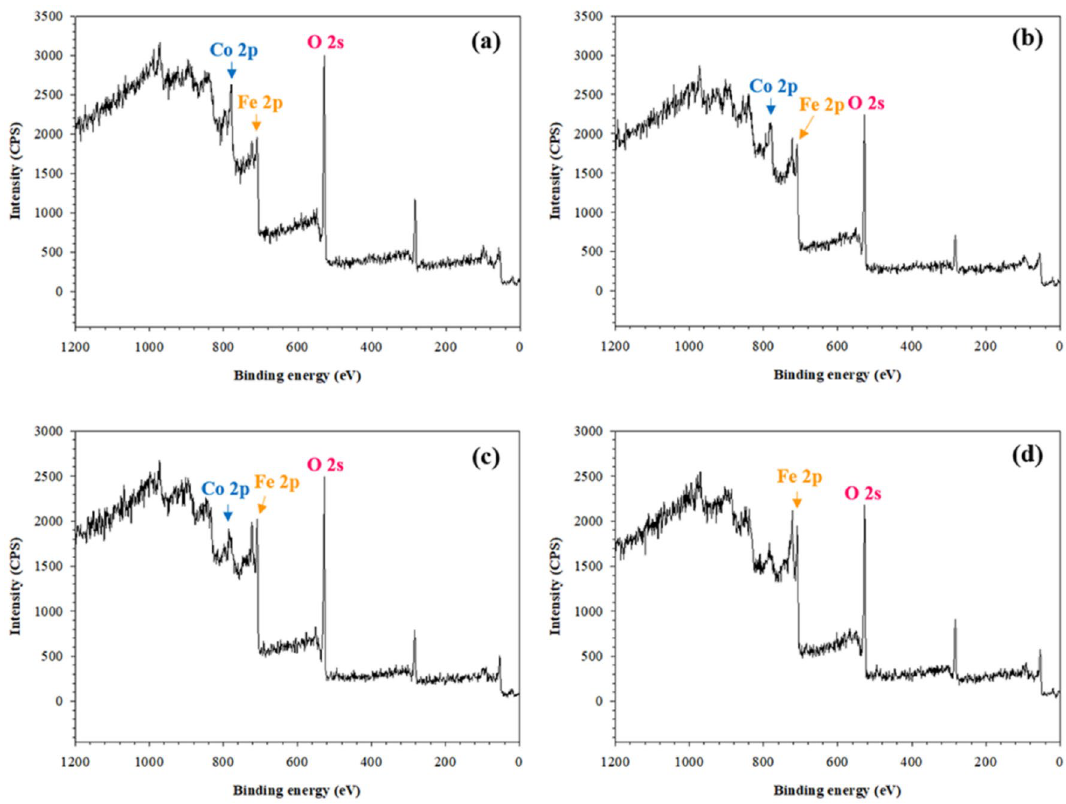
Figure 5. XPS spectra of the Co x Fe 1−x Fe 2 O 4 : ( a ) CoFe 2 O 4 _SDS_1.2CMC; ( b ) Co 0.6 Fe 0.4 Fe 2 O 4 _SDS_1.2CMC; ( c ) Co 0.2 Fe 0.8 Fe 2 O 4 _SDS_1.2CMC; and ( d ) Fe 3 O 4